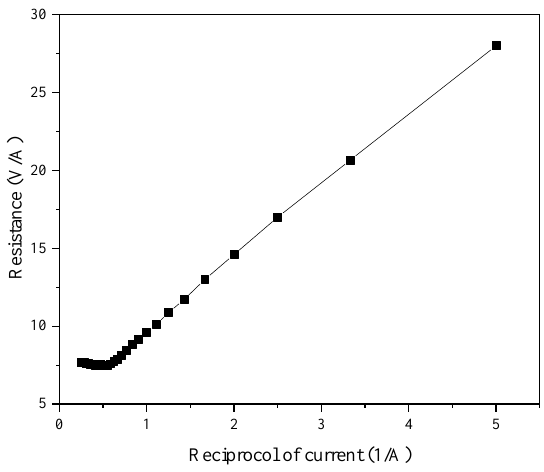
Figure 14. Limit current measurement curve.